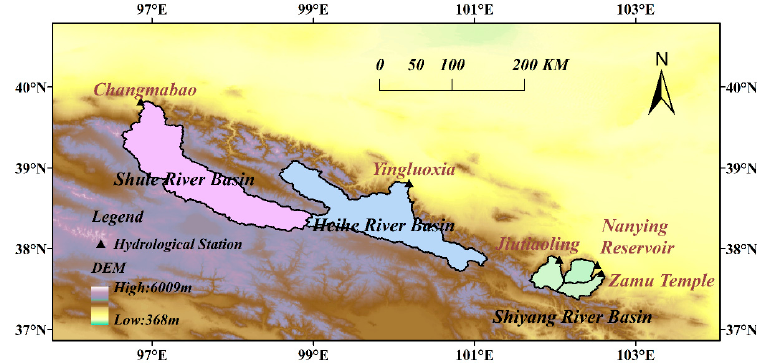
Atmosphere 2023 , 14 , x FOR PEER REVIEW Figure A2. Overview of basins of the Hexi inland river. Figure A2. Overview of basins of the Hexi inland river.